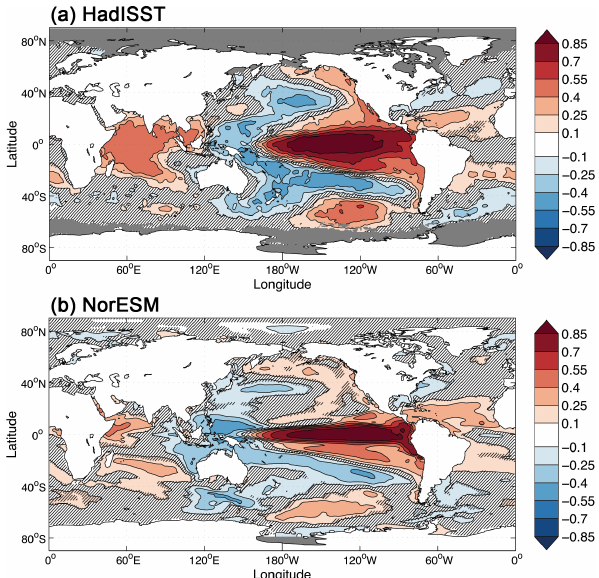
Fig. 18. Correlation between local and NINO34 region SST anomalies for (a) HadISST and (b) Historical1. The anomalies are found by subtracting the monthly means for the whole time series that span years 1900–2005 for both data sets. Hatched area indicates regions where the correlation is not significantly different from vanishing correlation at the 95% confidence level. In the estimation of confidence intervals, the number of degrees of freedom is adjusted due to autocorrelation according to Quenouille (1952).